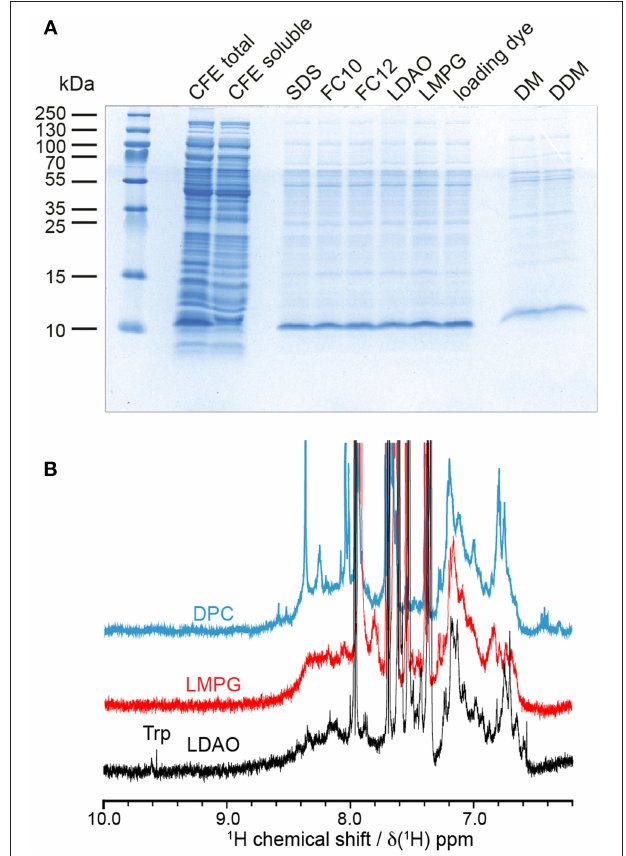
FIGURE 4 | Solubility and NMR properties of barttin in different detergent micelles. (A) Coomassie stained SDS-PAGE solubility screen using CFE pellets directly solubilized with indicated detergents (for different detergents only the soluble fraction after centrifugation at 20,000 g is loaded into the gel). (B) 1D 1 H NMR screening of resulting most promising barttin containing